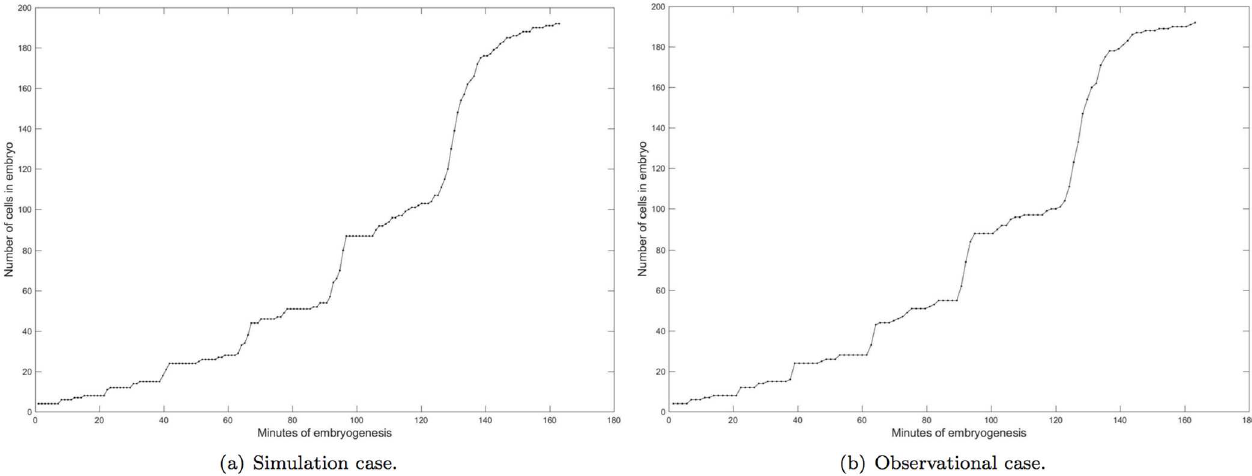
Fig 4. Number of cells in embryo over time. Figure shows the number of cells in the simulation/real embryo from the beginning to * 180 minutes, from 4-cell stage to *